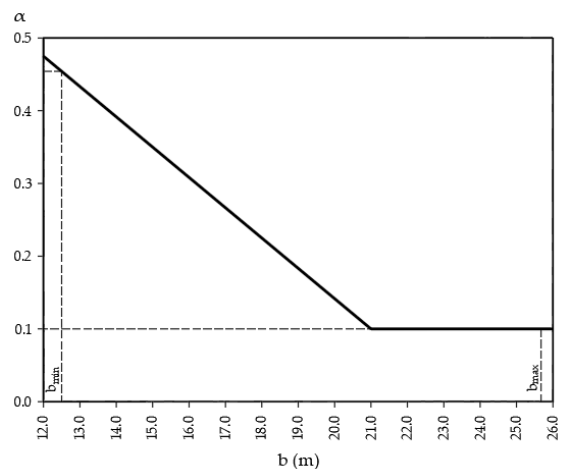
Figure 6. Conflict factor reflecting the impact of exiting traffic on entry capacity by the distance between exiting and entering traffic streams along the center of the circulatory lane.